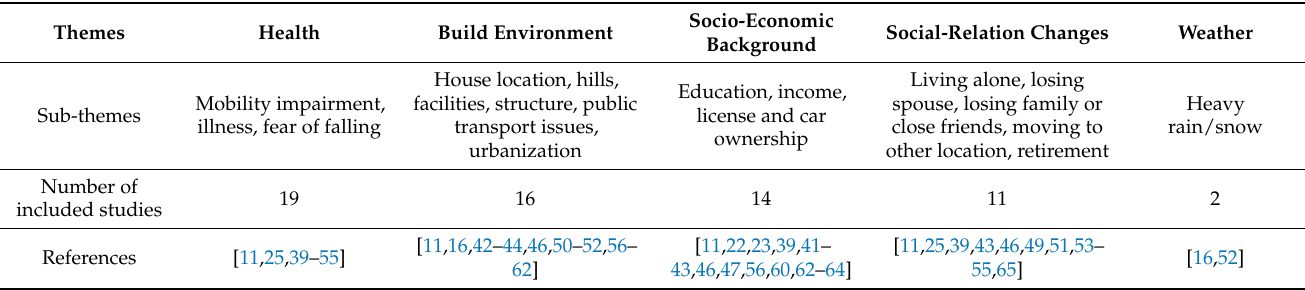
Table 1. Mobility barrier theme, derived from included studies using